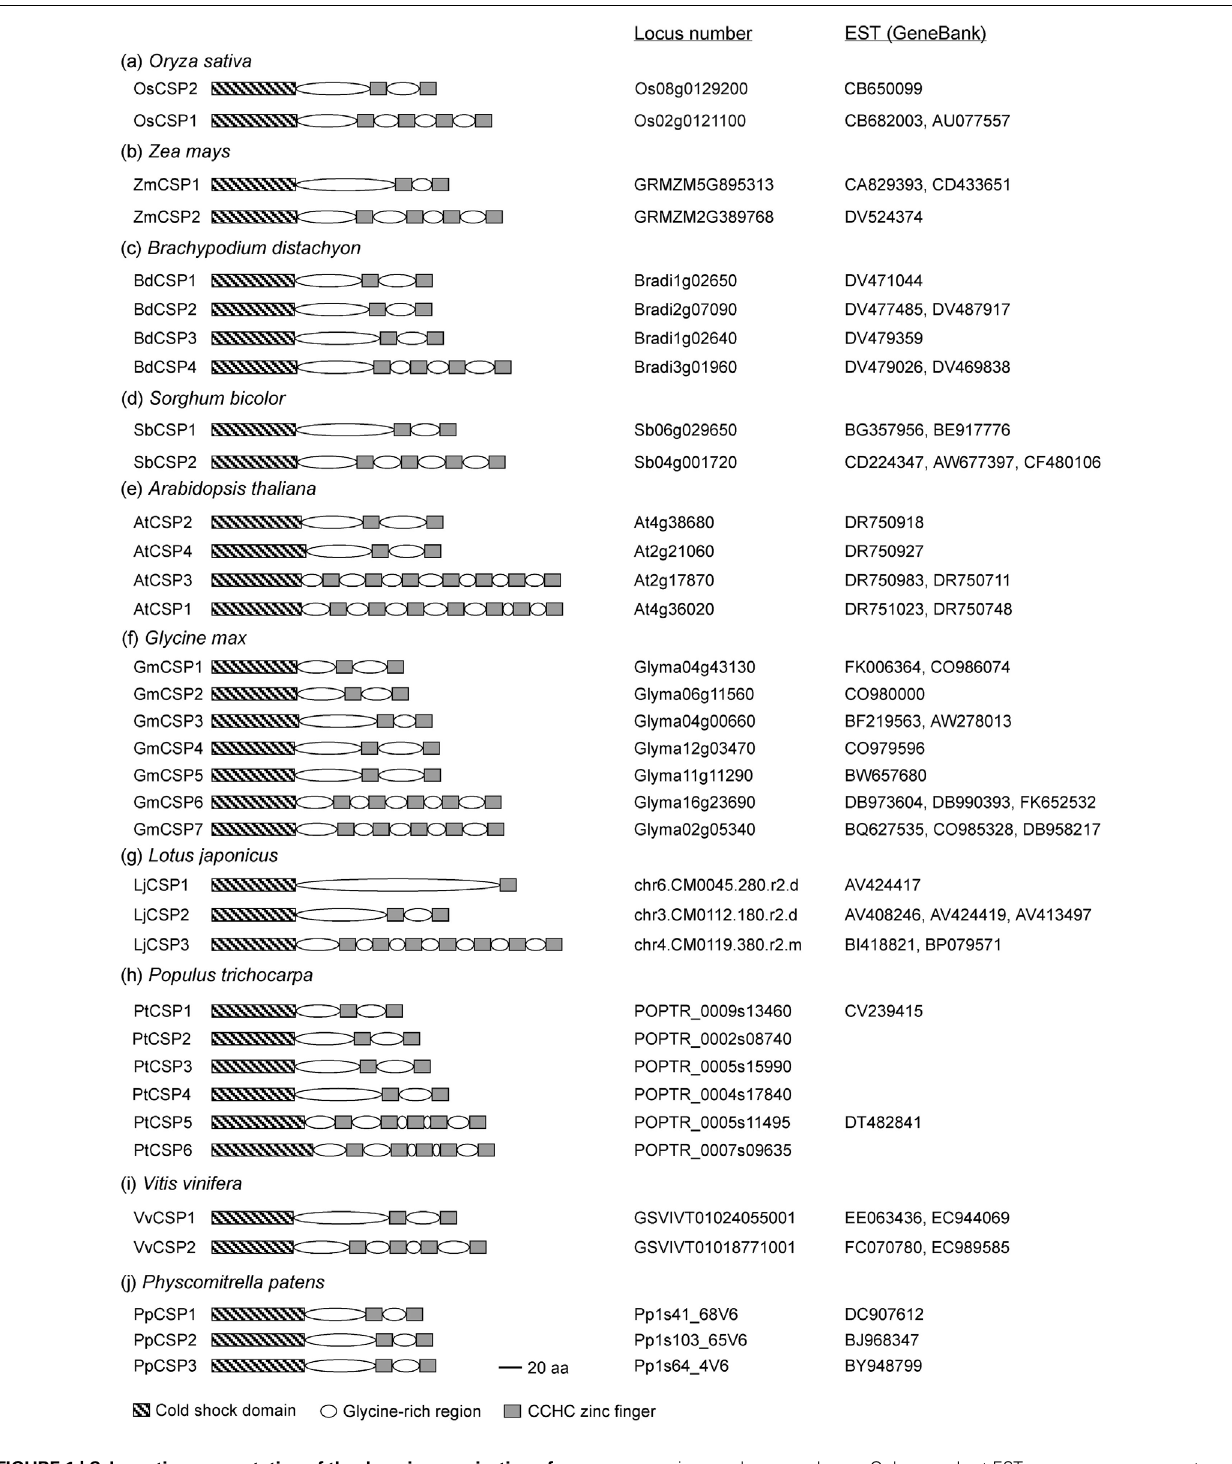
FIGURE 1 | Schematic representation of the domain organization of cold shock domain proteins in plant species whose genome sequences are available. Locus numbers and corresponding EST